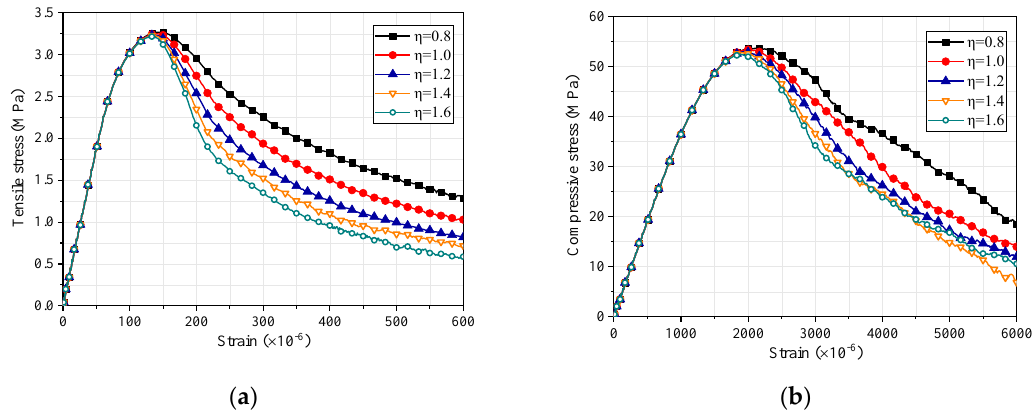
Figure 17. Effect of material parameter on global stress-strain relationship under ( a ) tension and ( b ) compression.